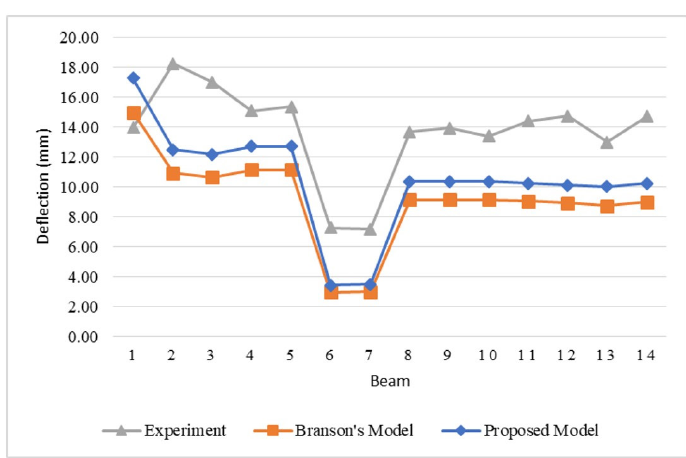
Figure 12. Beams with reinforcement rate from 2 to